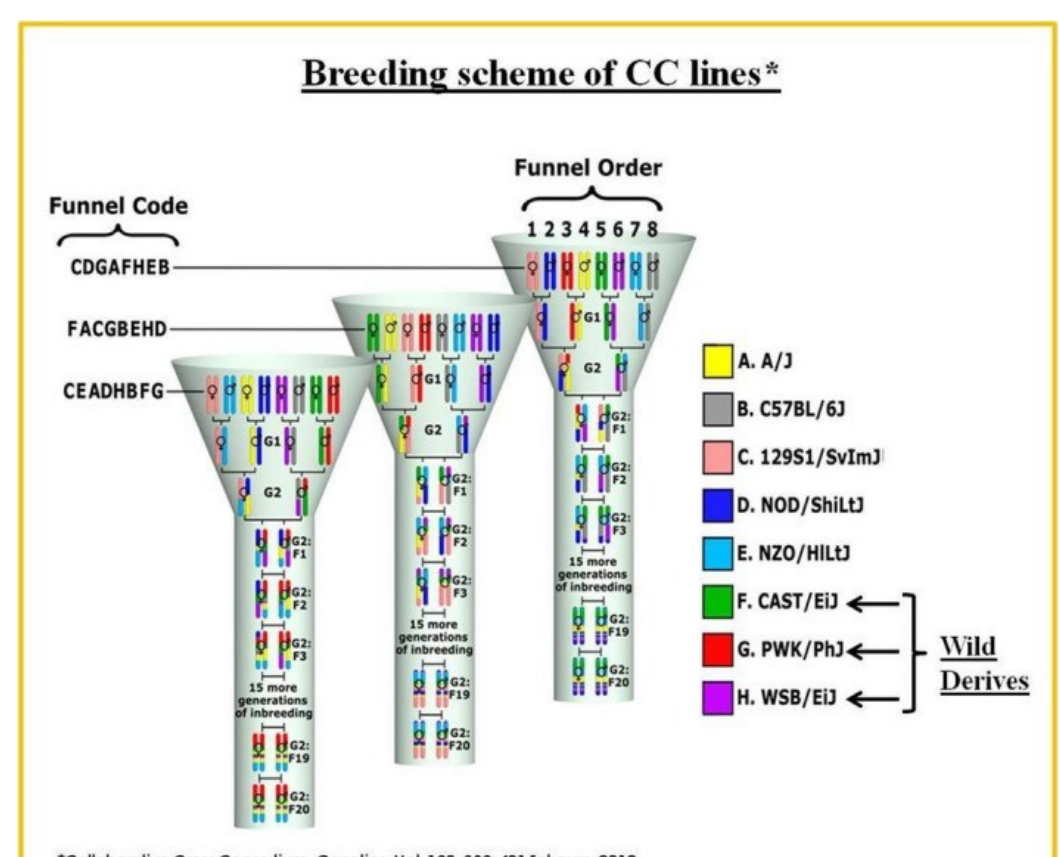
Figure 1. The development of the Collaborative Cross (CC) mouse model. This breeding approach was designed to randomize the genetic composition of each inbred line. A single breeding funnel results in a recombinant CC inbred line representing the genomes of the eight founders of CC mice. The eight founding tribes are arranged in different positions. Each CC line originates from an independently breeding funnel of eight CC founders so that at every recombination site in the CC population is uniquely generated.